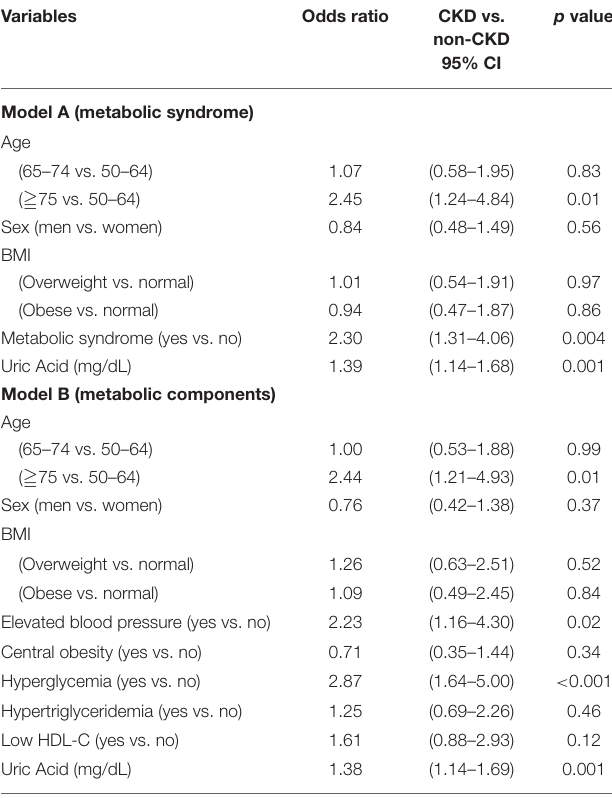
TABLE 3 | Multiple logistic regressions: the effects of metabolic syndrome and metabolic components on the chronic kidney disease among screened